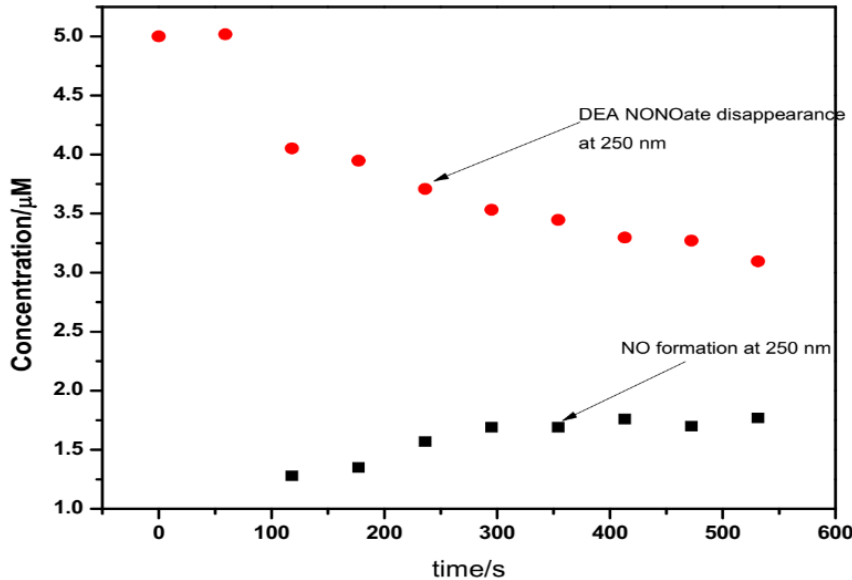
Figure 10. UV data for both decomposition of DEA NONOate and production of NO measured λ = 250 nm in a 0.1 M PBS.